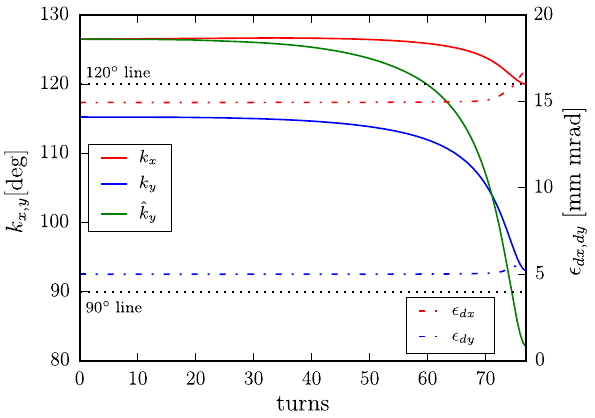
FIG. 12. Space-charge depressed phase advances k lines) solved from the coupled envelope approach and emittance growth ϵ (dashed line) from PIC simulations during bunch dx;dy compression with doubled bunch intensity and k 0 118 k 0 ;y ¼